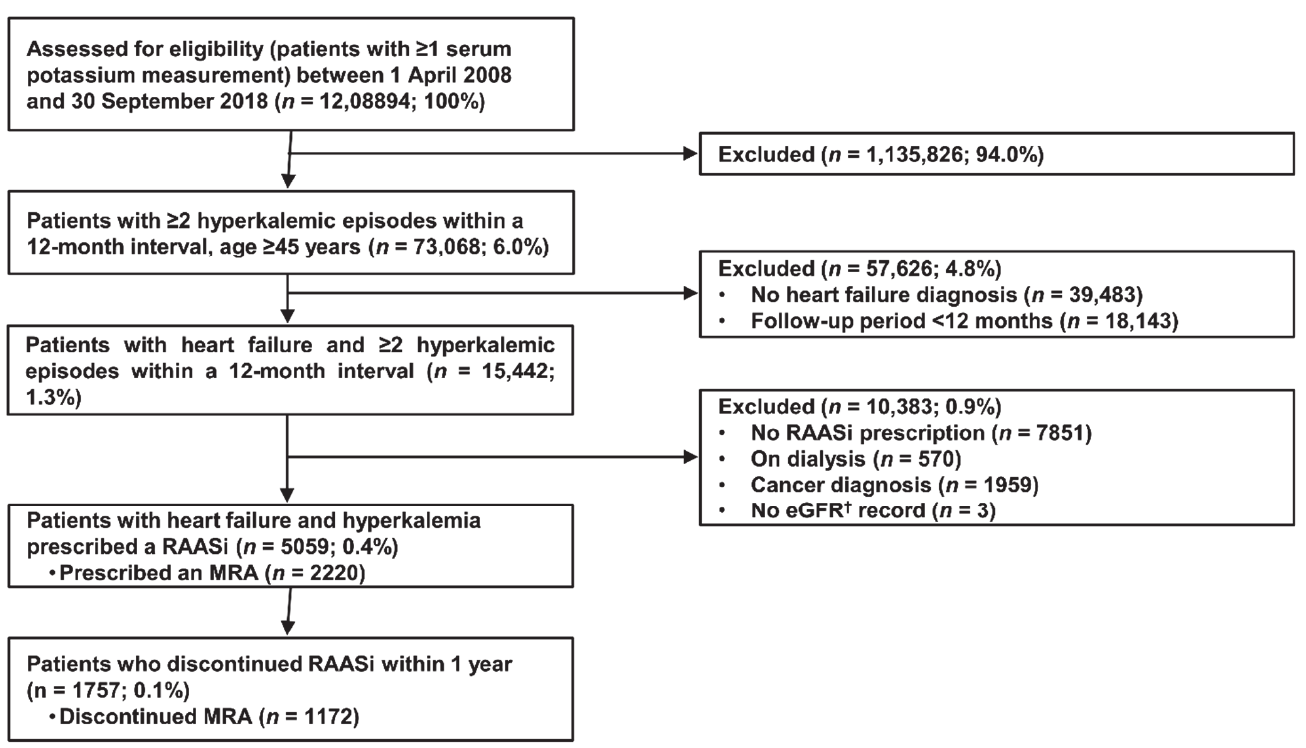
Figure 1. Flow diagram of patient inclusion in the study. Abbreviations: eGFR, estimated glomerular filtration rate; MRA, mineralocorticoid receptor antagonist; RAASi, renin–angiotensin–aldosterone system inhibitor.